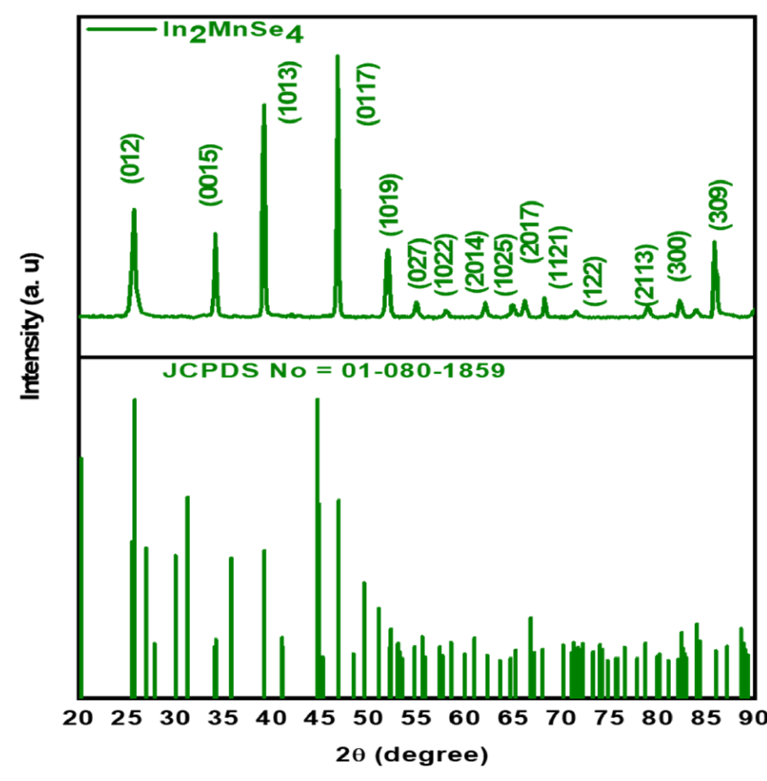
Figure 1. XRD diffractogram of the fabricated In 2 MnSe 4 nanostructure.